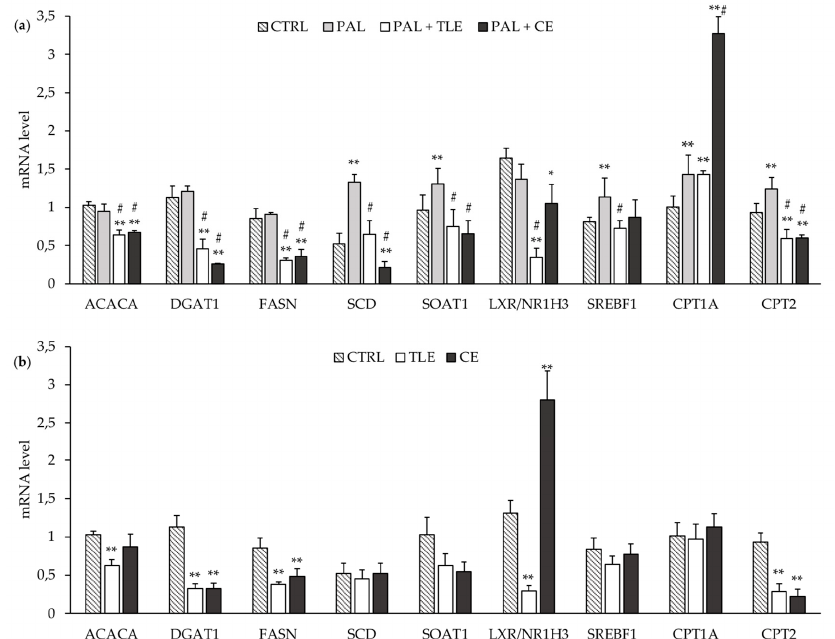
Figure 3. Impact of total lipophilic and carotenoid extracts from P. tricornutum on mRNA levels of several genes involved in lipid metabolism regulation in palmitate (PAL)-treated HepG2 cells ( a ) and control (CTRL) cells ( b ). The HepG2 cells were treated with control medium and 1.16% ethanol (CTRL), PAL (250 µM) alone or associated with total lipophilic extract (PAL + TLE , 100 µg/mL ) or carotenoid extract ( PAL + CE , 6 µg/mL ) for 24 h before RNA extraction. mRNA levels of genes were quantified using RT-qPCR. Data are the means ± standard deviations from at least three independent experiments. Statistical significance was determined using ANOVA with post-hoc Fisher’s test, and asterisk(s) indicate significant differences compared to the CTRL vehicle with * p < 0.05 and ** p < 0.001. Hashtags indicate significant differences compared to the PAL vehicle with # p < 0.001.